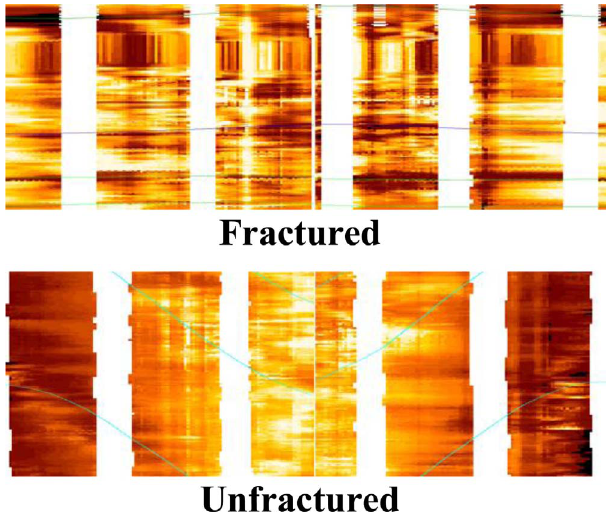
Figure 4. Formation acoustic image log images.